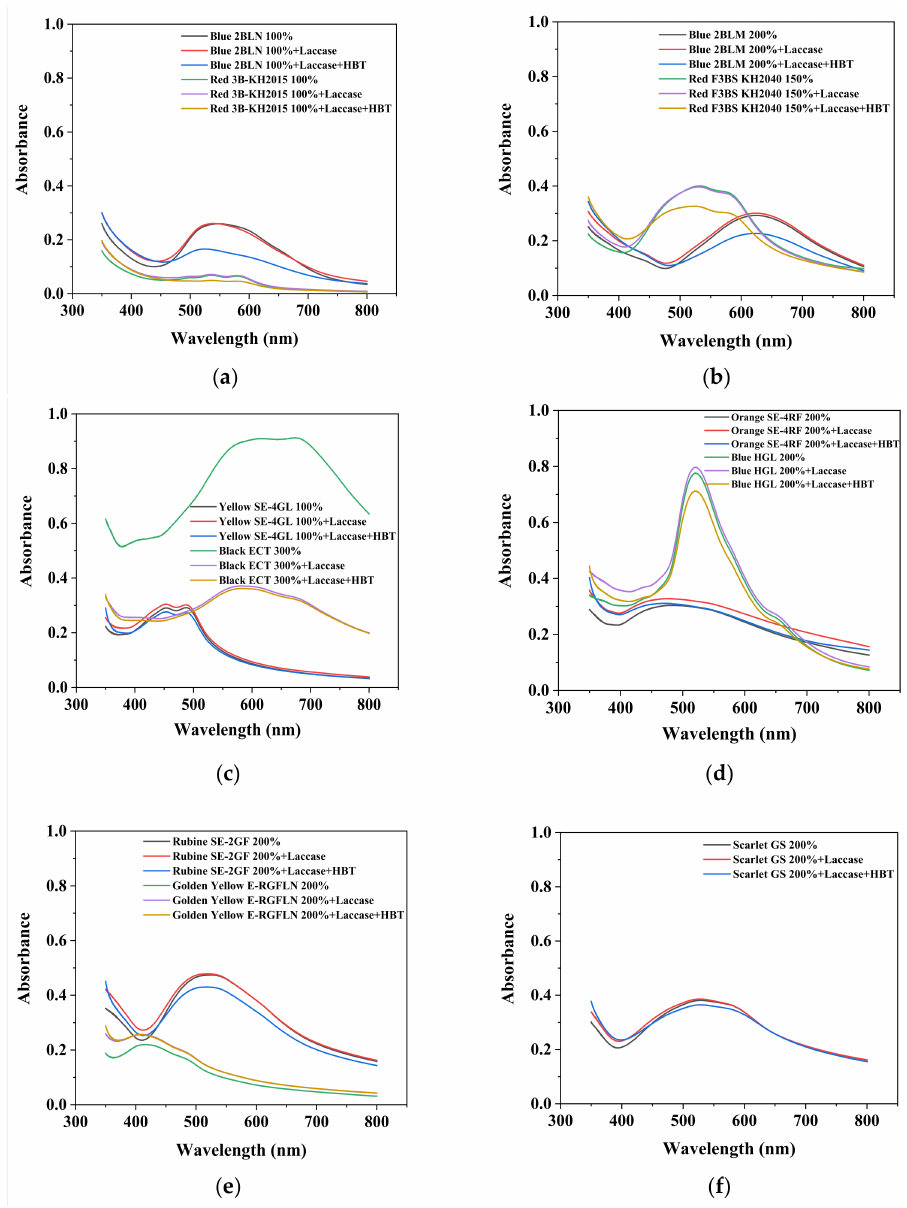
Figure 1. UV-Vis spectra of disperse dye solution (50 mg/L) before and after laccase (0.165 U/mL) or laccase (0.165 U/mL) + HBT (0.15 mmol/L) treatment. pH of each solution was natural and temperature was 25 ◦ C. ( a ): Blue 2BLN 100% and Red 3B-KH2015 100%; ( b ): Blue 2BLM 200% and Red F3BS KH2040 150%; ( c ): Yellow SE-4GL 100% and Black ECT 300%; ( d ): Orange SE-4RF 200% and Blue HGL 200%; ( e ): Rubine SE-2GF 200% and Golden Yellow E-RGFLN 200%; ( f ): Scarlet GS 200%. It can be seen from Figure 1 that the absorbance values of most dyes decreased to varying degrees at the individual maximal absorption wavelength, with the exception of Golden Yellow E-RGFLN 200% and Orange SE-4RF 200%, which showed a slight increase in the absorbance. This indicated that the majority of disperse dyes could be successfully decolorized by laccase alone or laccase + HBT. The most significant decolorization was found for Black ECT 300% using laccase with or without the addition of mediator HBT, followed by Blue 2BLN 100% and 200%, Red F3BS KH2040 150%, and Red 3B-KH2015